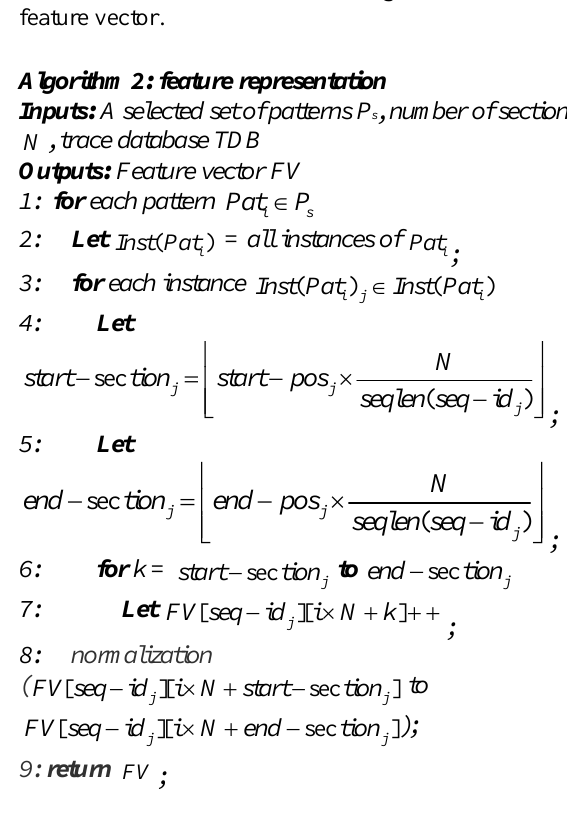
Algorithm 2 presents the pseudo code for position distribution based feature